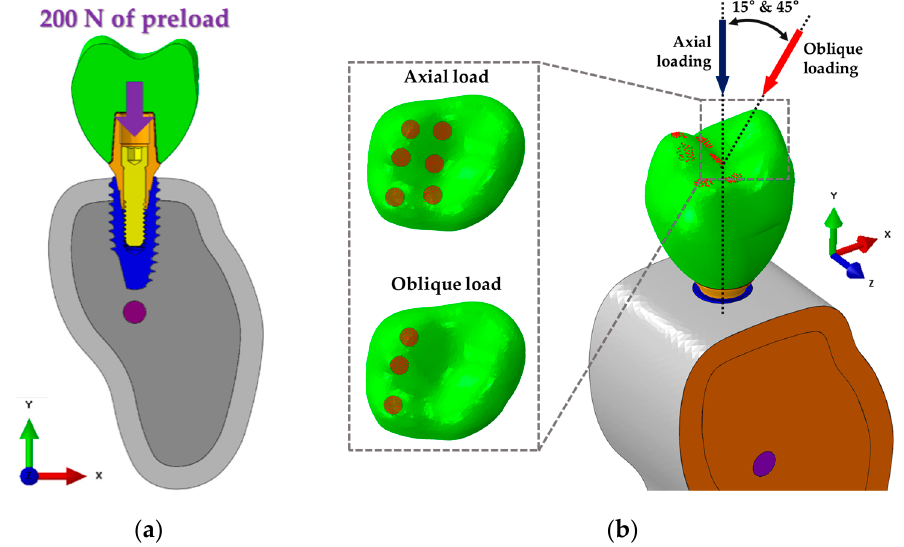
Figure 4. Boundary and loading conditions of FEA models (IS-II and IS-III). Both sides of the bone model (orange) are fixed in all axes. ( a ) Application of 200 N in the axial direction to the screw assuming the complete connection of the fixture and abutment. ( b ) Total load of 100 N applied to 187 nodes on 6 cups in the axial direction of the fixture and total loads of 100 N (15°) and 30 N (45°) applied to 86 nodes on 3 fossae and 3 cups in a non-axial direction considering the various directional loads.